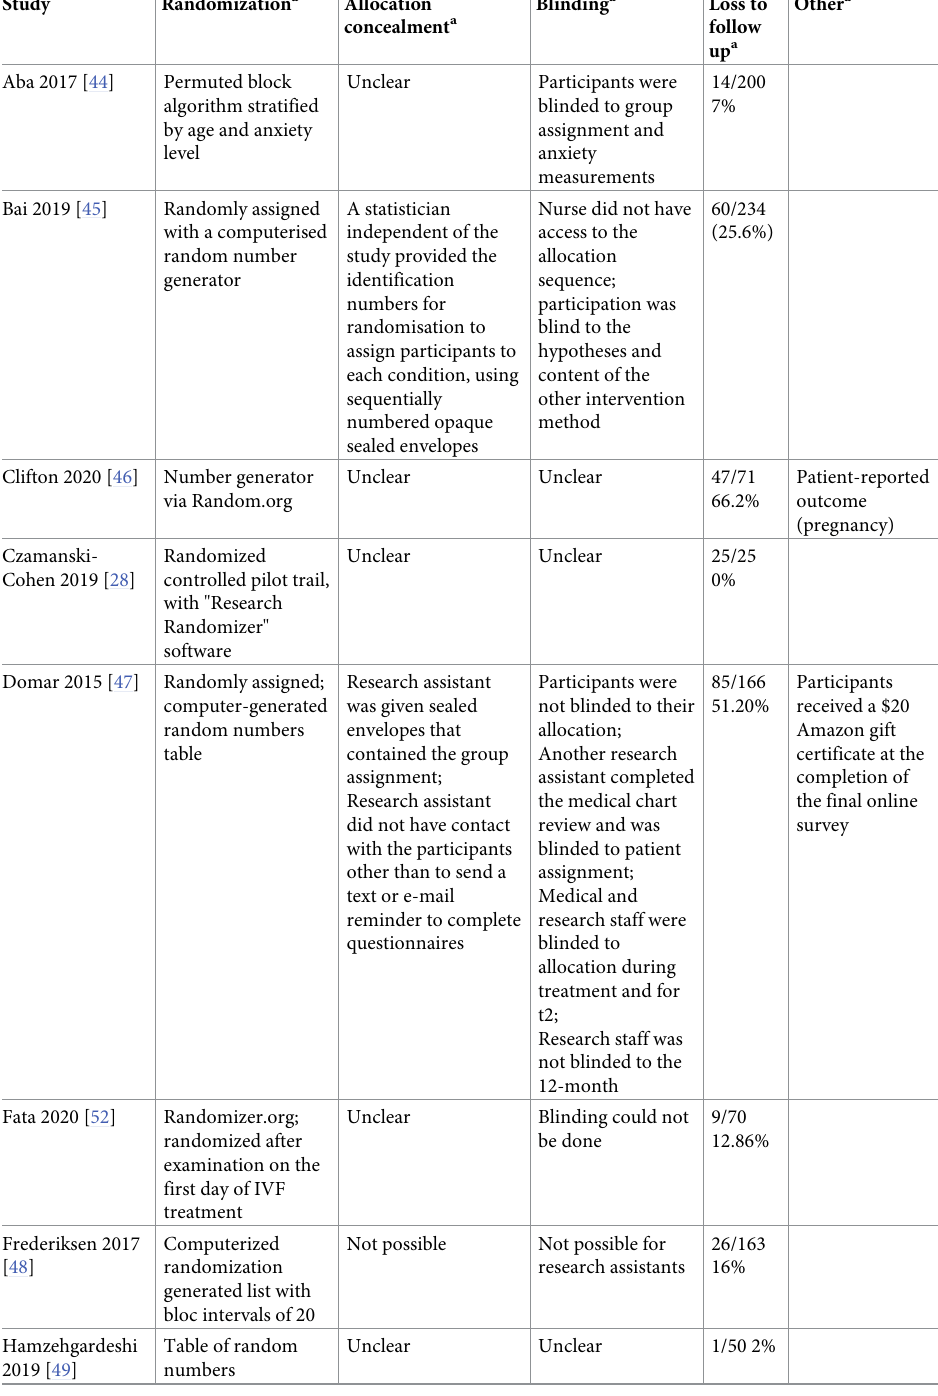
Table 7. Risk of bias in the measurement of anxiety, depression and pregnancy rates in studies on the effect of psychosocial interventions in infertile women following GRADE